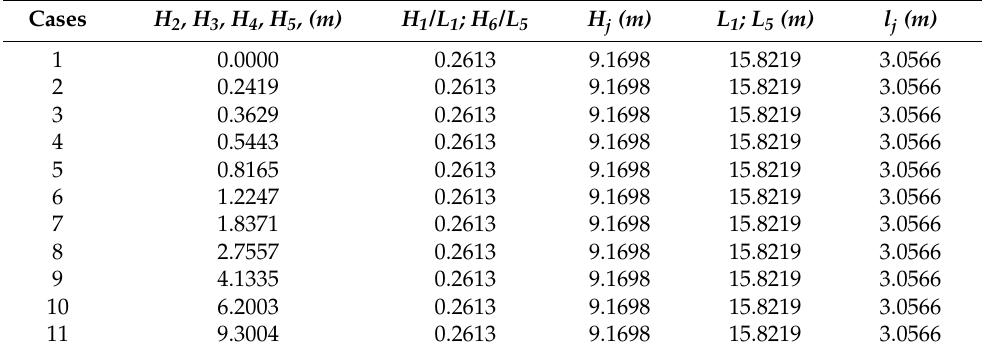
Table A2. Geometric variation in the height of the columns that divides the devices, with five coupled chambers.